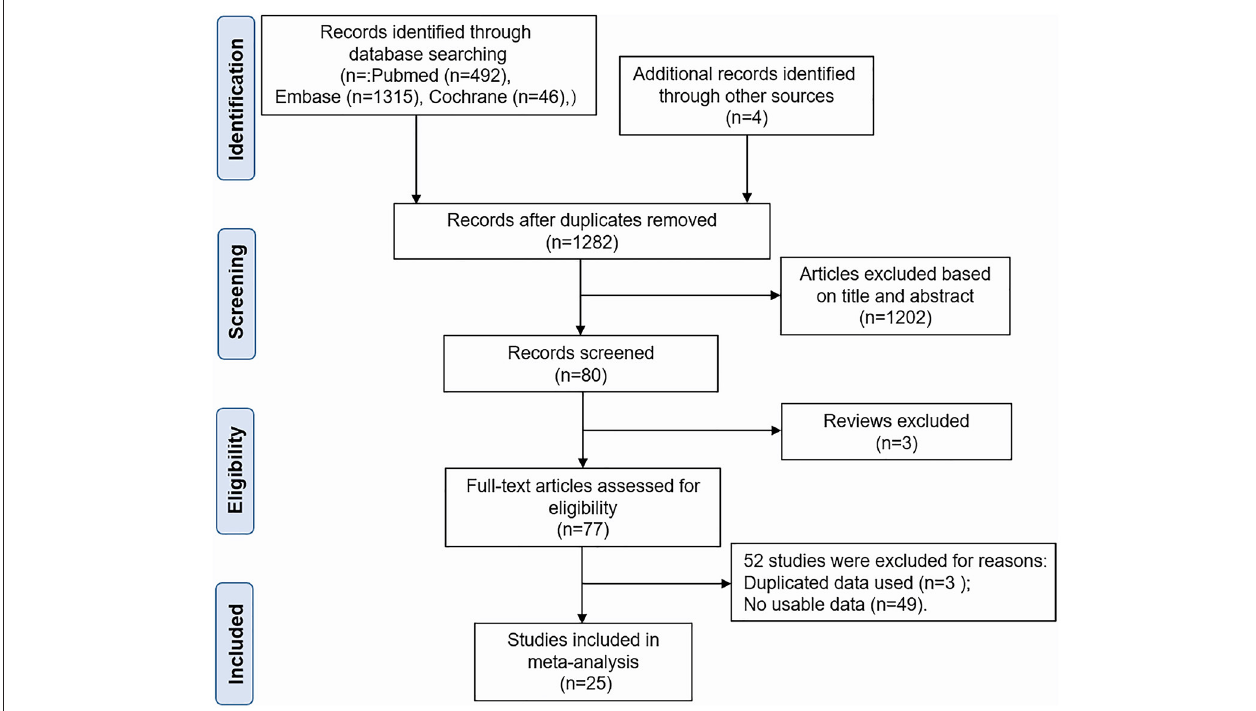
FIGURE 1 | Flow diagram of the selection of studies for